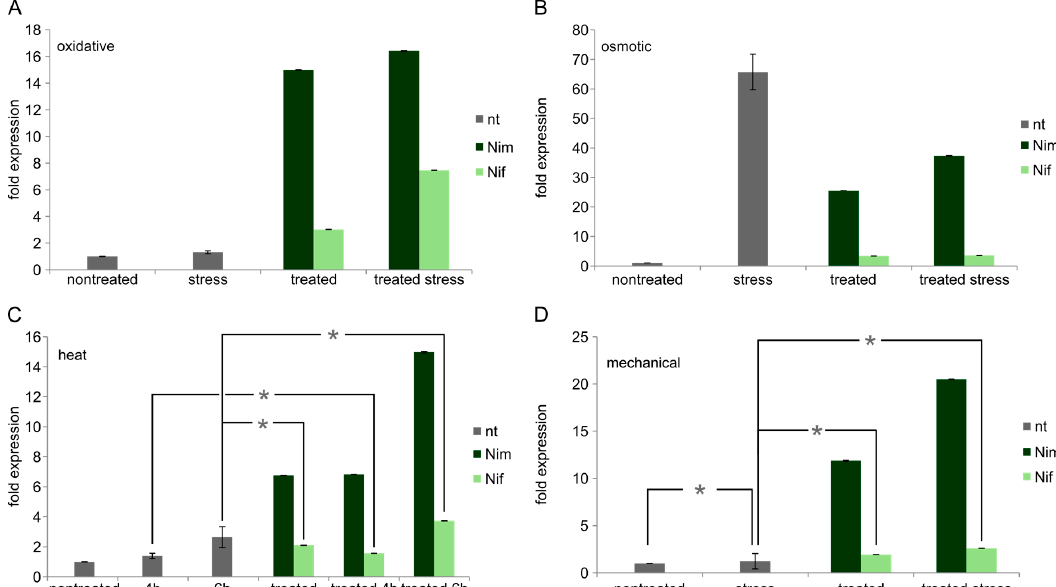
Figure 4. FA2H mRNA levels in differentiated Neuro2a cells. Values are given as the mean ± SD (error bars) of one representative out of at least three biologically independent experiments. ( A )